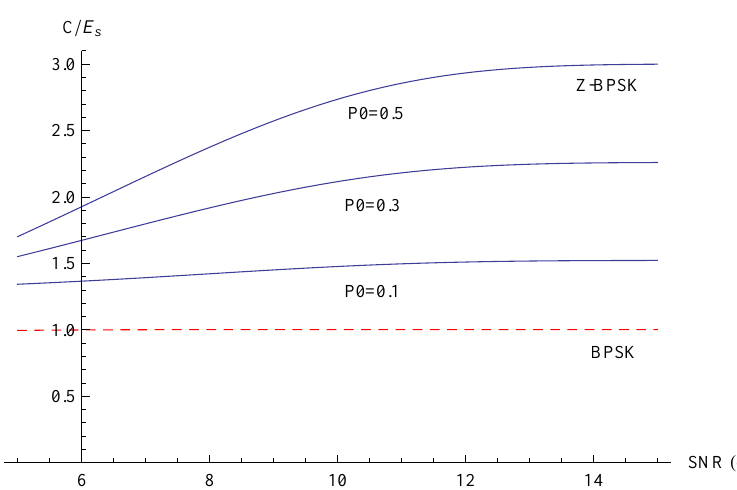
Figure 5. Energy capacity of the Z-BPSK and BPSK as a function of the SNR for different values of P 0 .